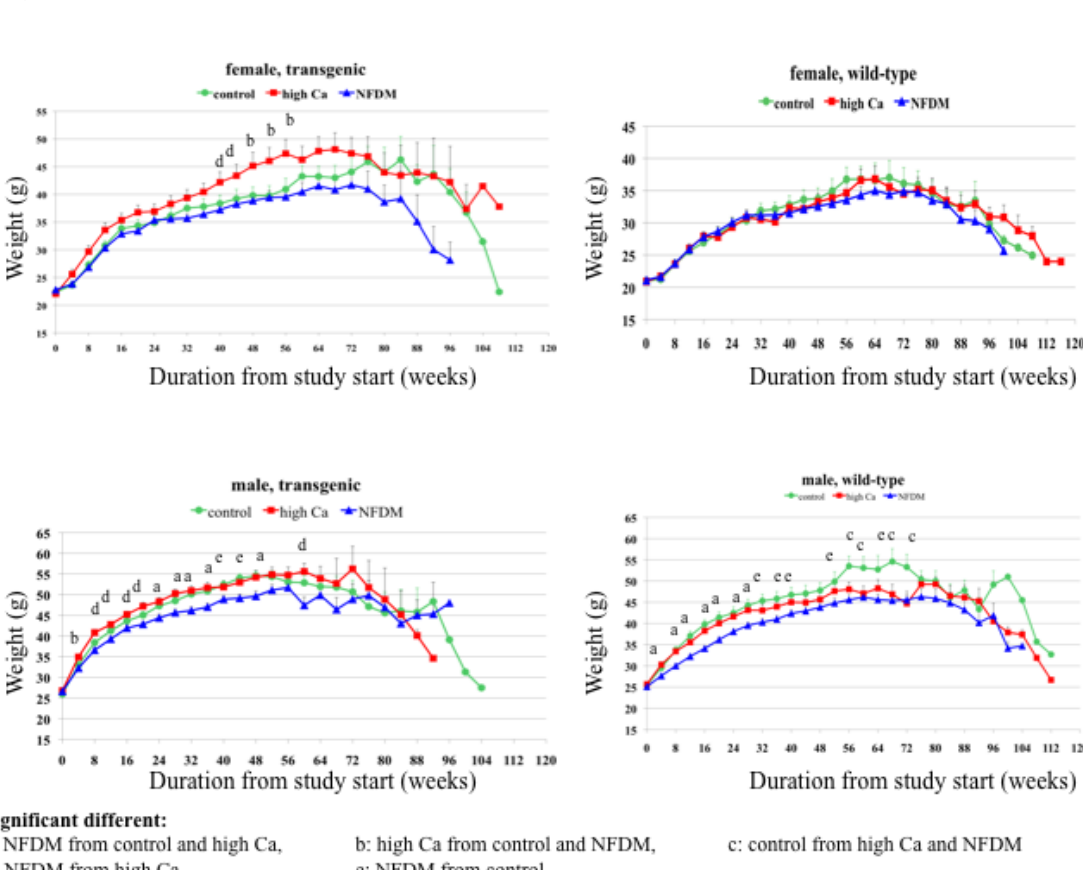
Figure 1. Mean weight distribution of all aP2-agouti transgenic and wild-type mice fed control, high calcium or NF DM diets over the study duration. Values are expressed as mean ± SE. Letters above curve denote significant differences between diet groups, p <